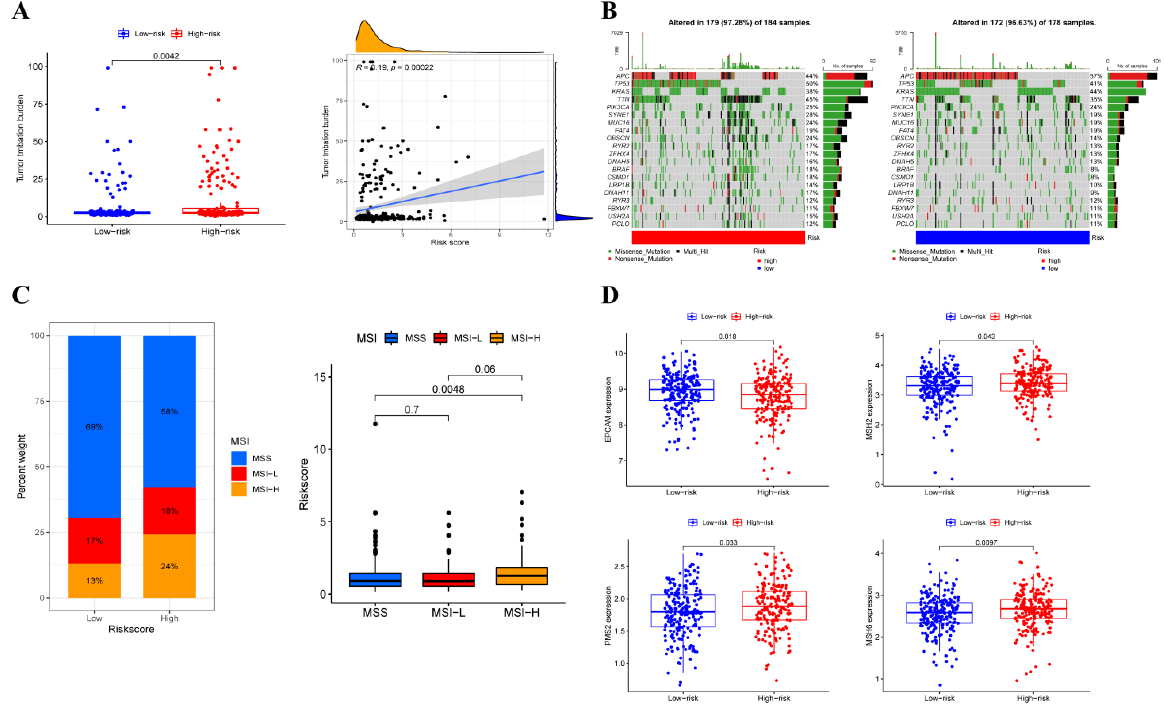
Figure 7. The relationship between TMB and risk score. ( A ) The difference between TMB in high- risk and low-risk groups and the correlation between TMB and risk score. ( B ) Waterfall plot revealed the mutation information of genes with high mutation frequency in high-risk and low-risk groups. ( C ) The proportion of different microsatellite states and the risk score of three microsatellite states in different risk groups. ( D ) The expression of EPCAM, MSH2, PMS2 and MSH6 in two risk groups.